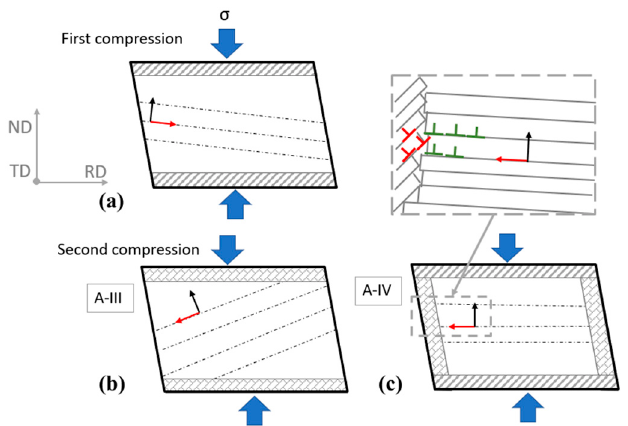
Figure 12. ( a ) depicts the sample geometry during the first loading. ( b , c ) represents the samples in reloading. Hatched area dictated the surface where stresses are applied in the first loading, and brick texture represents the surfaced constrained by plane strain condition initially. The slip system, taken as the alignment direction of the most apparent DBs set in EBSD MOA maps, comprises the slip direction (red arrow) and the slip plane (black arrow). For sample A-IV, the red crosses and green crosses represent the dislocation generated in the first compression and second compression, respectively.